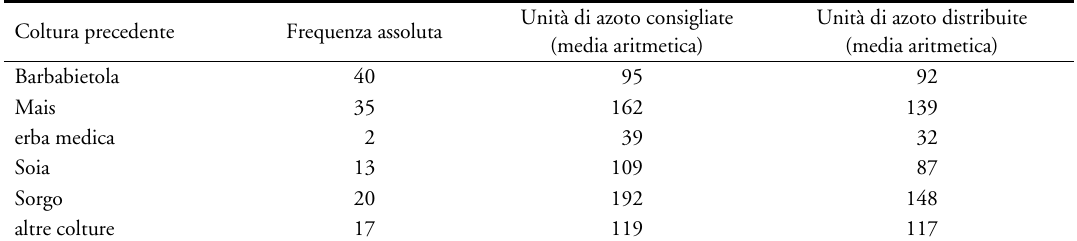
Figura 1 – Unità (Kg/ha) di azoto distribuite (in ordinata) dai cerealicoltori e unità di azoto consi- gliate (in ascissa). TAVOLA 2 Valori medi della quantità di azoto consigliata (in Kg/ha) e di quella distribuita sugli appezzamenti con la medesima precessione